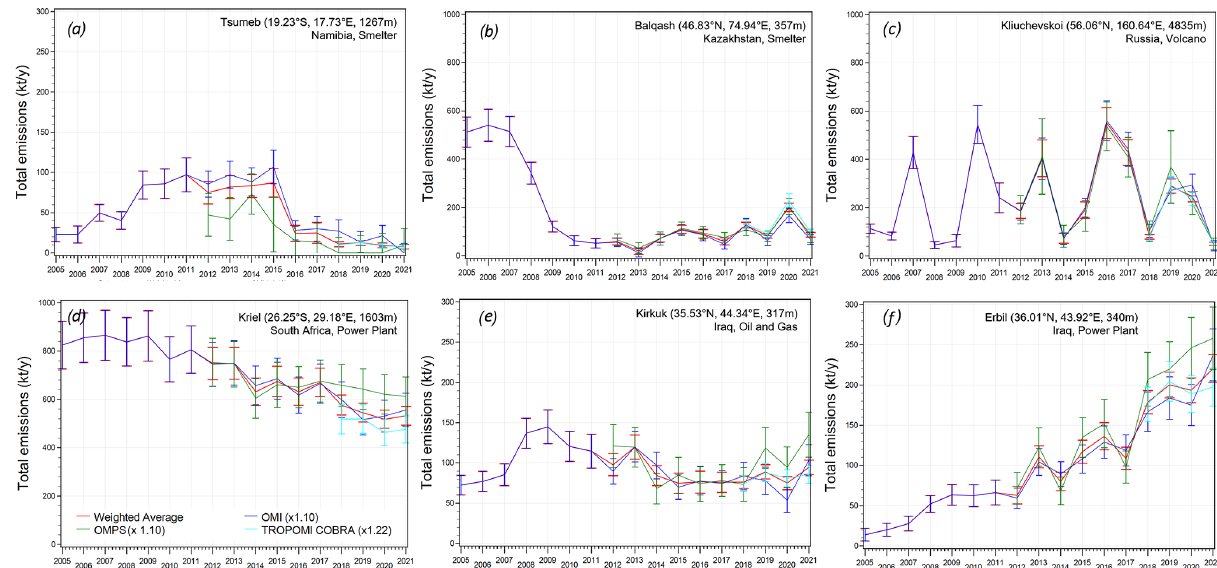
Figure 4. Annual emission estimates from the three satellite data sources: OMI (blue), OMPS (green), and TROPOMI (cyan), and their weighted average (red) with 2 σ error bars. TROPOMI-based estimates were increased by 22% and OMI and OMPS data were increased by 10% as discussed in the text. The emission source names, types, coordinates, and elevations above sea level are shown.